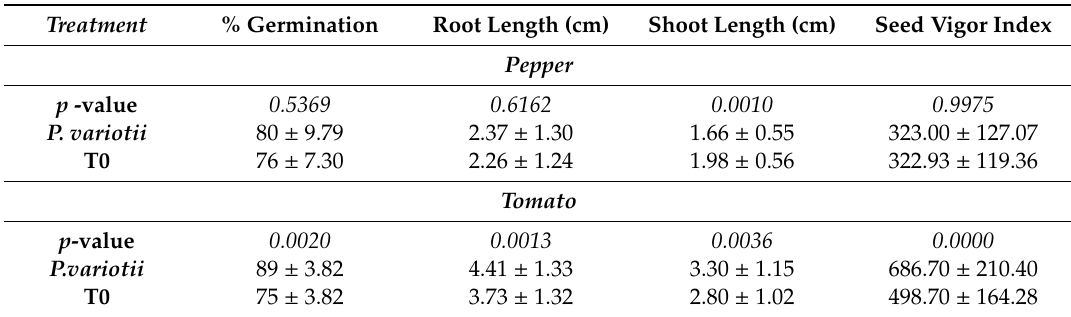
Table 2. E ff ects of P. variotii isolate on tomato and pepper seed germination 7 and 10 d after treatment, respectively.